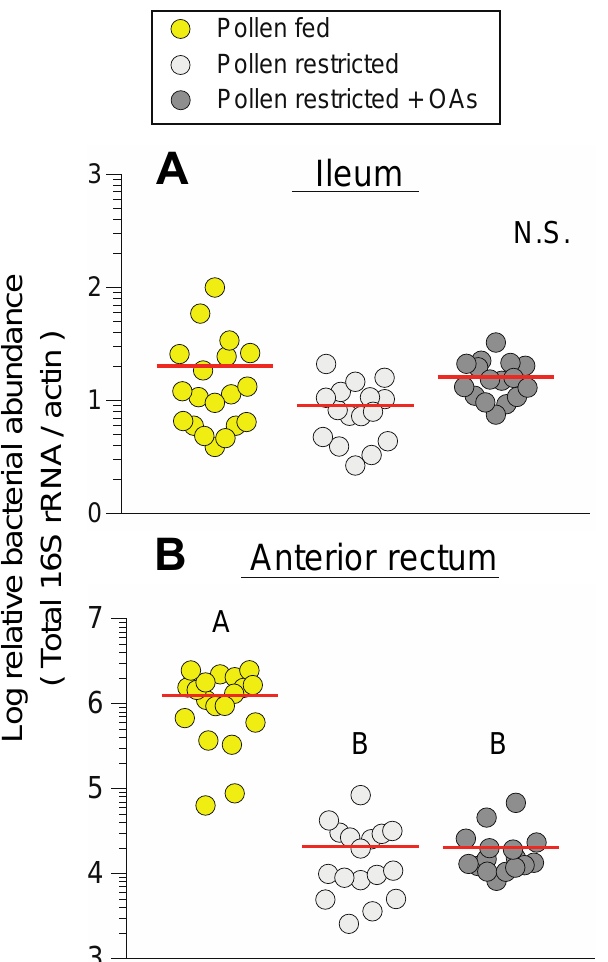
Figure 2. Relative bacterial 16S rRNA abundance in honey bees subjected to different diet treatments (pollen-fed, pollen restricted, pollen restricted + organic acids (OAs)). (A) Relative ileum 16S abundance. (B) Relative anterior rectum 16S abundance. Each point represents a pooled sample from an independent cage ( n = 16–19 cages). Black horizontal lines indicate the mean. Different letters indicate Tukey HSD P < 0.05.